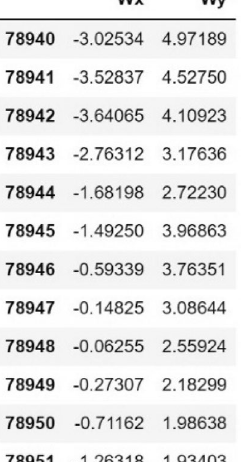
Fig. 25 Validation output data